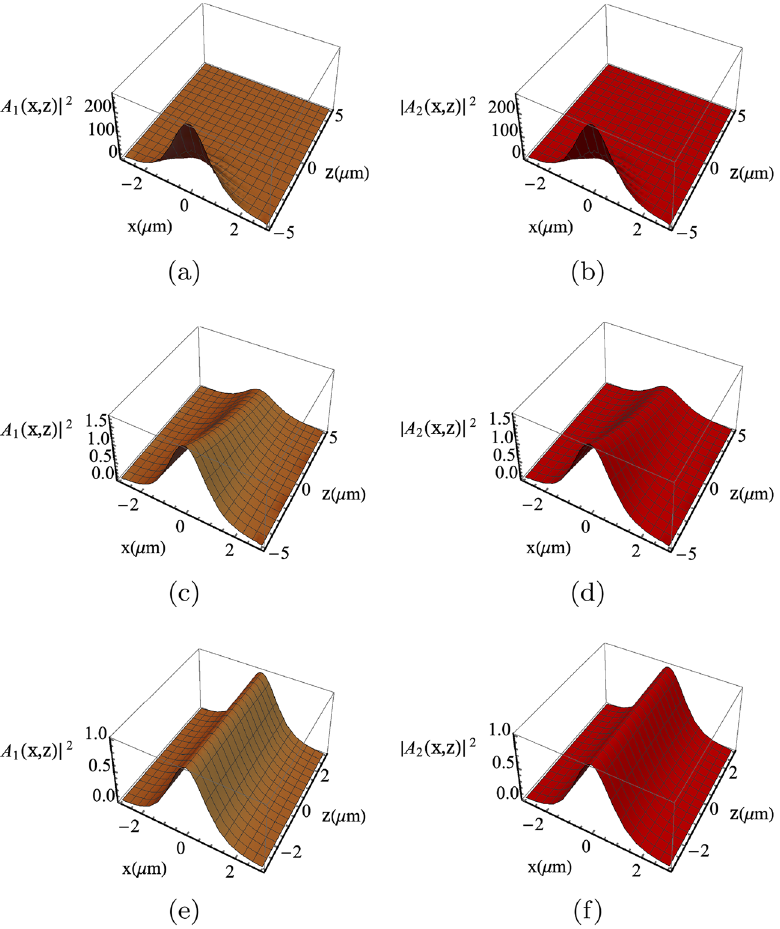
Figure 3. Solitons profile considering different microwave voltages amplitude (i.e., ν ). The solitons profile 1 mV ( a , b ), ν 0.1 mV ( c , d ) and ν 1 µ V ( e , f ), respectively. The solitons profiles are displayed for ν = = = 5 µ m in ( e , f ), while distorted even for a relatively are preserved for significant propagation distance ∼ 1 2 µ m in ( a , c or b , d ). The other parameters are ω 1 2 π 193 THz , short propagation distance ∼ − = × 2 π 120 GHz , the period length a 1 µ m , the number of graphene 2 π 192.88 THz and ω ω 2 m = × = = × 2 , the susceptibility χ 2 10 14 m 2.095 f , loss factor 10 , the intrinsic electron density n 0 layers N − = × = = 1 THz and the permittivity ǫ Ŵ ( 3.5 ) 2 = =